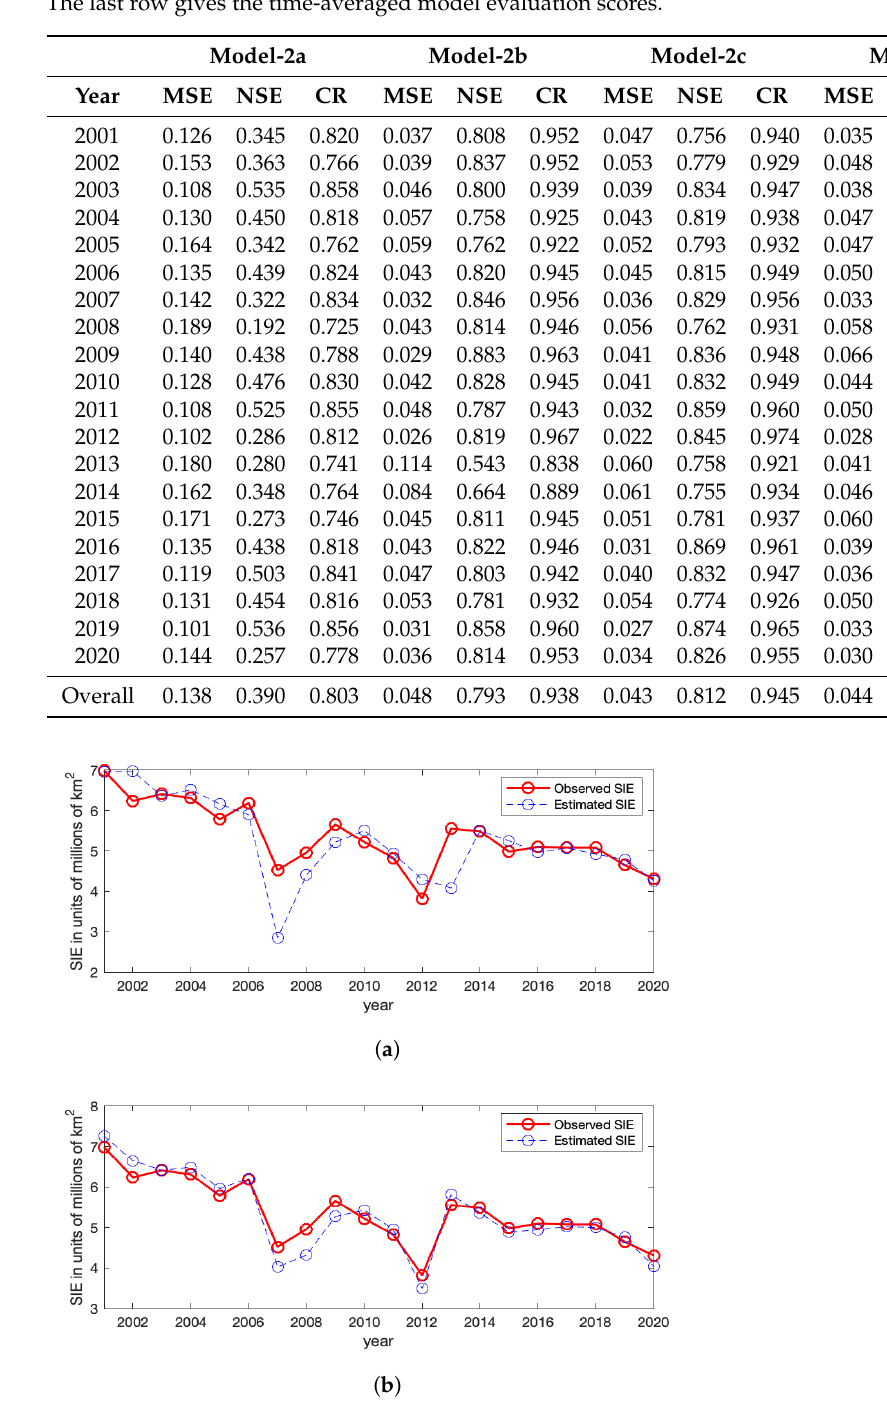
Figure A4. The observed Arctic SIE versus the estimated Arctic SIE using Model-1a and Model-2a (with the CS-RSR covariate). ( a ) Observed (red solid line) and estimated (blue dashed line) Arctic SIE using Model-1a with coefficients { β 0 , η 0, t , η 1, t } . ( b ) Observed (red solid line) and estimated (blue dashed line) Arctic SIE using Model-2a with the CS-RSR